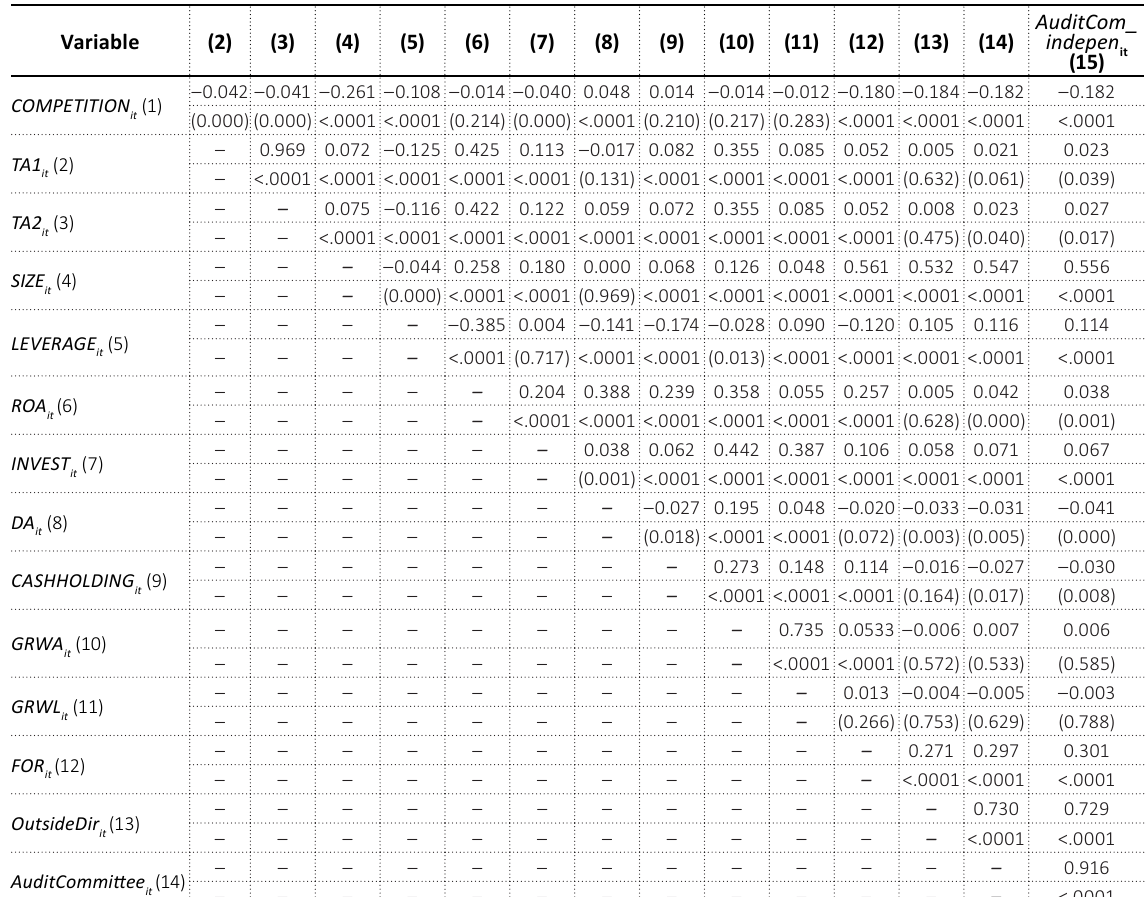
Table 3. Correlations ( p -values below)